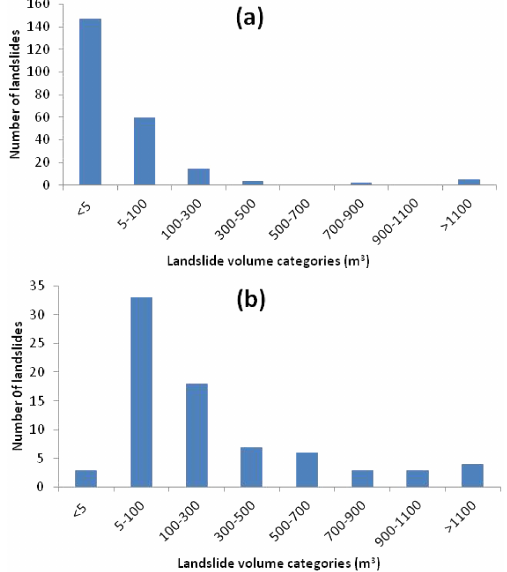
Figure 6. Size distribution for all surveyed landslides from (a) cut slopes ( n = 235) and (b) fill slopes ( n =